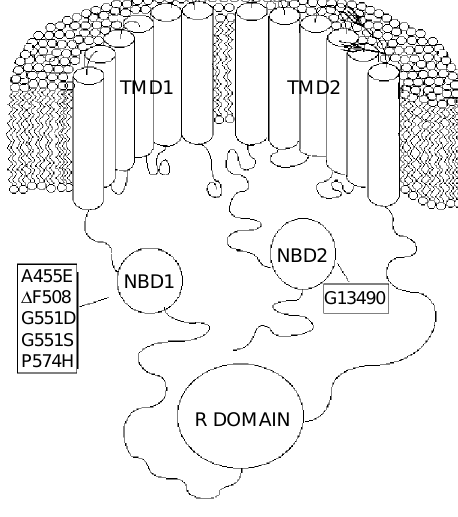
Figure 1 - Illustration of the pre- dicted two-dimensional or sec- ondary structure of the CFTR protein. The CFTR domains are shown. TMD1 and TMD2: trans- membrane-spanning domains 1 and 2, respectively; R domain: regulatory domain; NBD1 and NBD2: nucleotide-binding do- mains 1 and 2, respectively. A summary of the selected and important mutations in NBD1 and NBD2 discussed in this re- view is also shown. Modified from Ref.